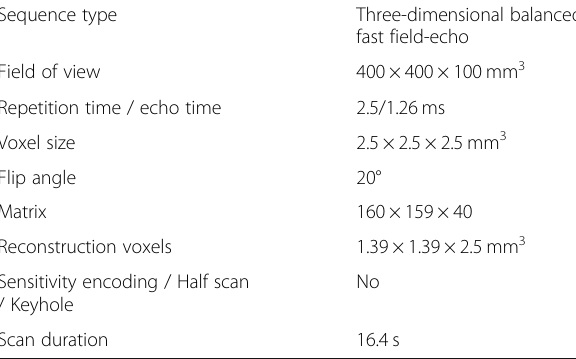
Table 1 Scan parameters of the fully sampled sequence Sequence type Three-dimensional balanced fast field-echo